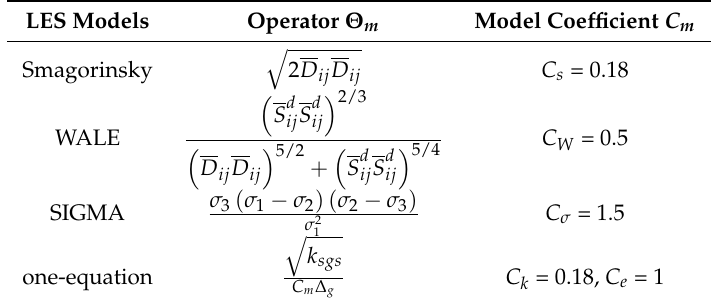
Table 1. Operator Θ m and model coefficient C m for various LES models applied. D ij is the filtered d strain rate tensor, k sgs the subsgrid-scale kinetic energy, S ij the traceless symmetric part of the squared velocity gradient and σ 1 , σ 2 , σ 1 are the three singular values of the velocity